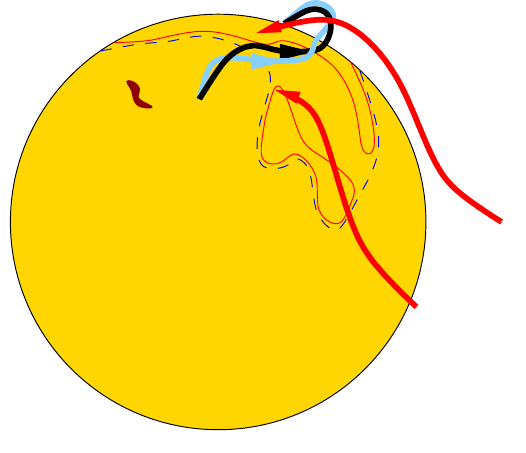
Fig. 7. Sketch of the prominence and the overlying coronal fields from the STA viewpoint based on the PFFS model in Fig. 6 and the wavelet enhanced EUV images (Fig. 7). The black and blue thick curves denote the prominence axial field and the red curves the open magnetic field lines to the northern coronal hole. The red thin curves outline the boundaries of the large polar coronal holes and the dashed curve shows the upper edge of the streamer belt. The dark red area to the left shows the location of AR 11007.